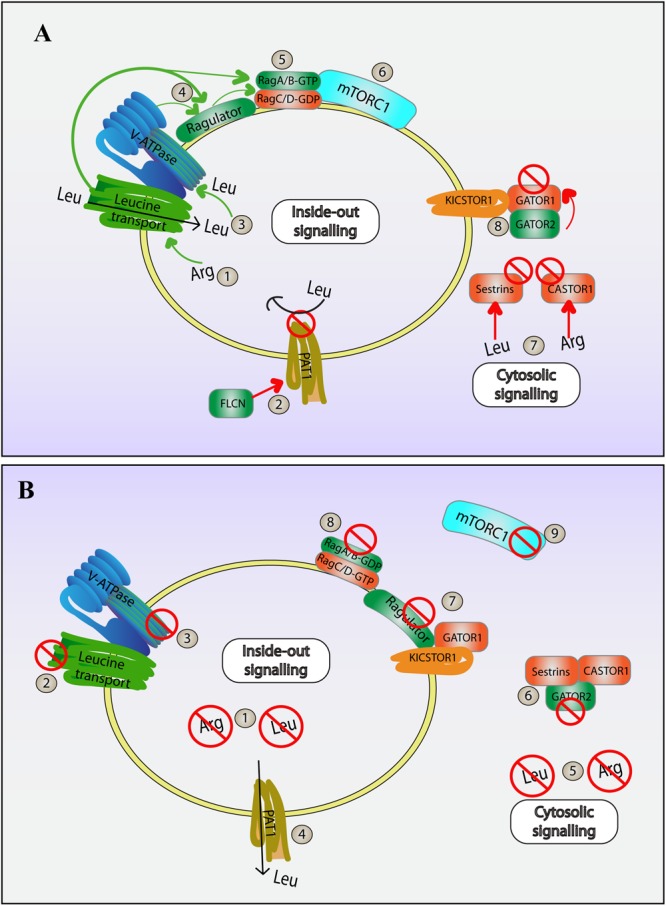
Amino acid dependent regulation of mTORC1. mTORC1 activity is modulated by the levels of specific amino acids within the lumen of lysosomes and in the cytosol. Information about luminal amino acids is transduced by an inside-out mechanism to mTORC1 present on the cytosolic surface, while cytosolic amino acid levels is sensed by cytosolic complexes that associate with the lysosome surface to modulate mTORC1. The following is a simplified series of steps that modulate mTORC1 both during high (A) and low (B) levels of leucine and arginine. (A) High amino acid conditions: (1) High levels of intraluminal arginine promotes leucine transport into the lysosome via SLC38A9. (2) FLCN-mediated inhibition of PAT1 amino acid transporter staunches leucine flow out of the lysosome, helping to amass leucine within the lysosome further; (3) Higher levels of leucine promote V-ATPase activity. (4) V-ATPase and SLC38A9 then promote Ragulator and interactions with Rag heterodimers. (5) Ragulator is a GEF for RagA/B, and together with folliculin, a GAP for RagC/D, helps form GTP-RagA/B::GDP-RagC/D heterodimer. (6) Active Ragulator and Rag heterodimers now recruit and activate mTORC1 on the lysosome surface. (7) Meanwhile, in the cytosol, cytosolic leucine and arginine bind to and inhibits sestrins and CASTOR1, respectively. This prevents sestrins and CASTOR from compromising GATOR2. (8) Ultimately, this allows for GATOR2 to bind and block GATOR1, a negative modulator of mTORC1. Together, both cytosolic and luminal amino acid sensors boost mTORC1 activity on lysosomes. (B) During low levels of amino acids: (1) Low intraluminal amino acids compromise inside out mediated activation of mTORC1. (2) The absence of arginine leads to a halt in leucine import via SLC38A9. (3) With no leucine in the lumen, the V-ATPase is unable to activate Ragulator and Rag GTPase heterodimers. (4) In addition, low cytosolic leucine prompts leucine export from the lysosome via PAT1, further depleting luminal leucine. (5) Decreased levels of cytosolic amino acids relieve sestrins and CASTOR1 from inhibition. (6) Free Sestrins and CASTOR1 can now bind and handicap GATOR2, freeing GATOR1. (7) GATOR1 is then recruited to the lysosome by the lysosome-associated KICSTOR, which further suppresses Ragulator/Rag GTPases. (8) Rag heterodimers take on GDP-RagA/B::GTP-RagC/D inhibitory conformation. (9) All these changes result in the release of mTORC1 from the lysosome and its suppression, thus initiating catabolic cellular programs.